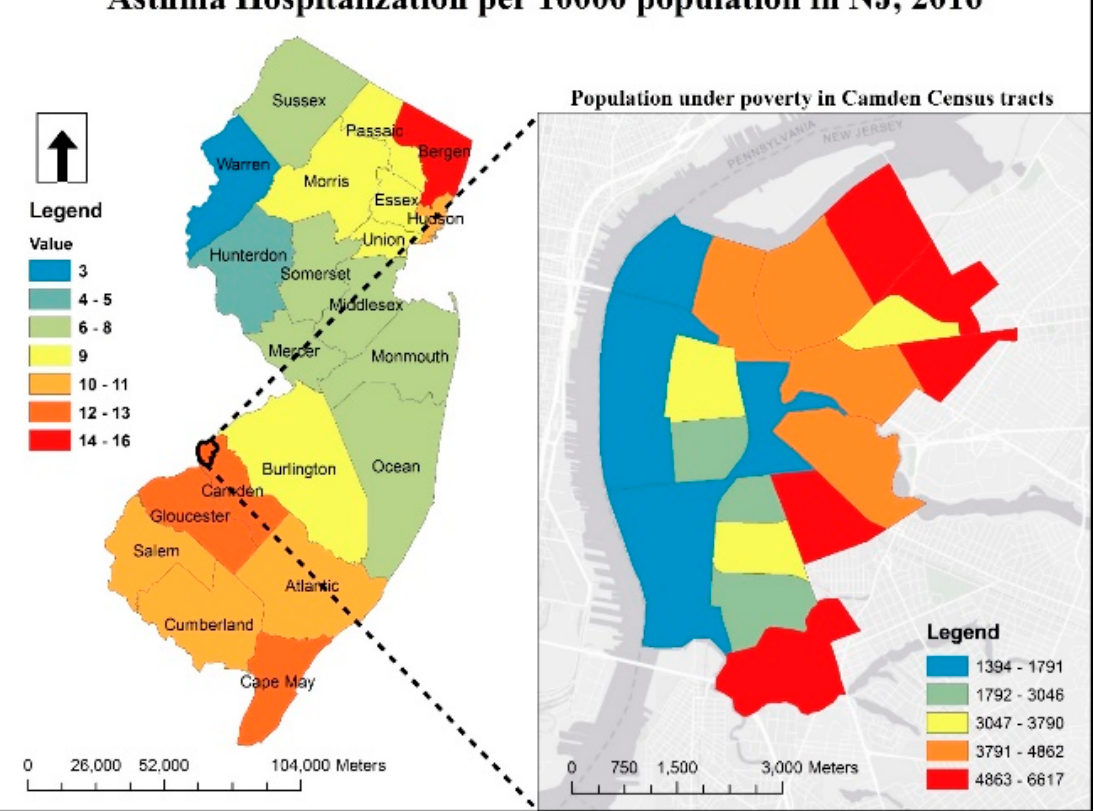
Figure 1. Asthma hospitalization crude rate per 10,000 population in New Jersey counties and Figure1. Asthmahospitalizationcruderateper10,000populationinNewJerseycountiesandpopulation population under poverty in Camden census-tracts in 2016. under poverty in Camden census-tracts in